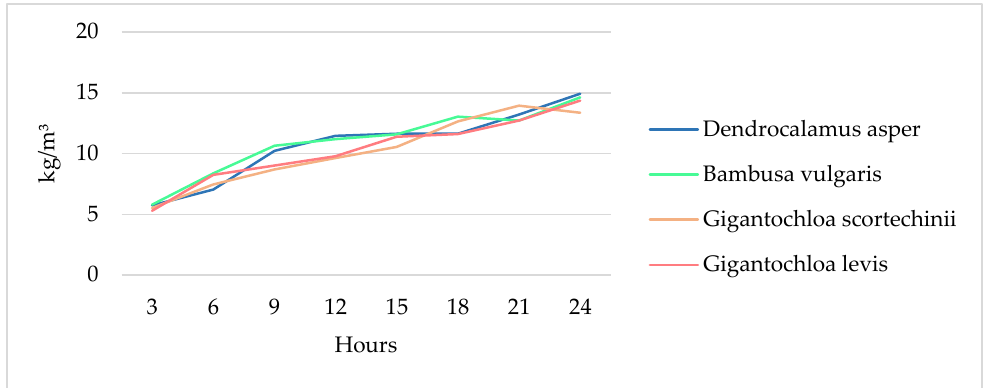
Figure 2. Mean dry salt retention of untreated and treated bamboo strips of four selected species.